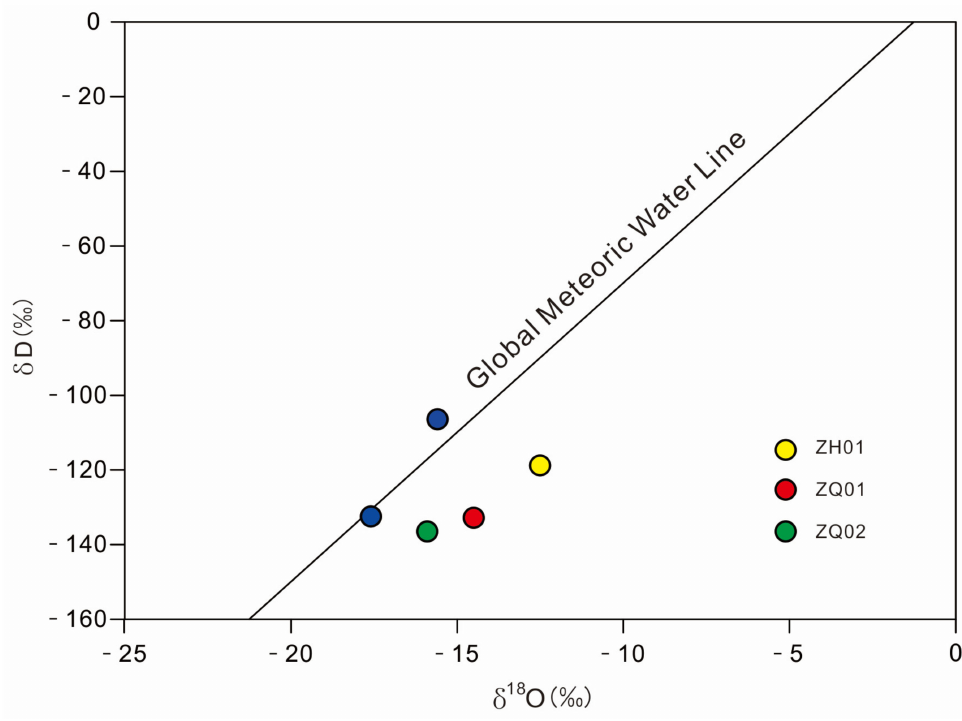
Figure 6. Plot of δ D- δ 18 O of Zabuye spring samples. Blue dot indicates data from